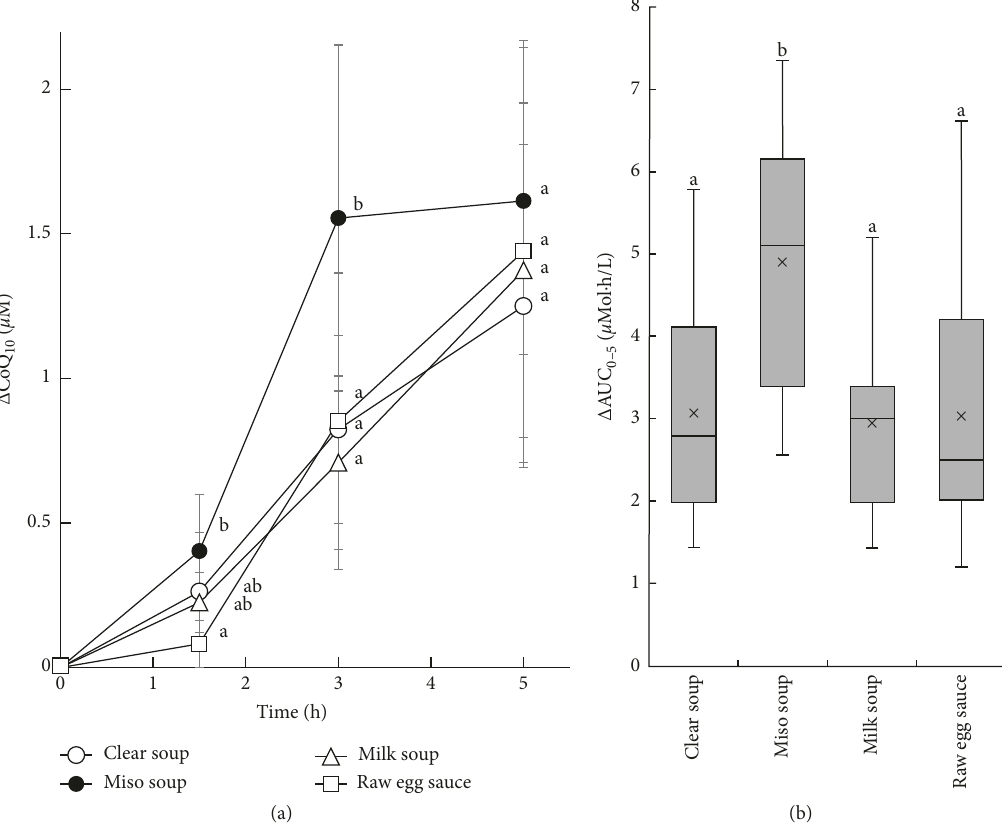
Figure 1: Changes in serum total CoQ 10 concentration (a) and a comparison of Δ AUC 0–5 (b) after the consumption of P30 in clear soup, P30 in miso soup, P30 in milk soup, or P30 in raw egg sauce. 120mg of CoQ 10 was administered. In Figure 1(a), the open circle represents P30 in clear soup, closed circle represents P30 in miso soup, open triangle represents P30 in milk soup, and open square indicates P30 in raw egg sauce. Data are mean ± SD for the eight individuals who participated in all four of the experiments. Figure 1(b) shows box plots for the Δ AUC 0–5 for these eight participants. The boundary of the box closest to zero indicates the 25th percentile, the line within the box indicates the median, the multiplication sign within the box indicates the mean, and the boundary of the box farthest from the origin indicates the 75th percentile. Whiskers above and below the box indicate the 10th and 90th percentiles. Data were analyzed with one-way analysis of variance with repeated measures, and differences between the means were evaluated using Holm–Bonferroni post hoc tests. Different lower case letters indicate significant differences, with P < 0 .